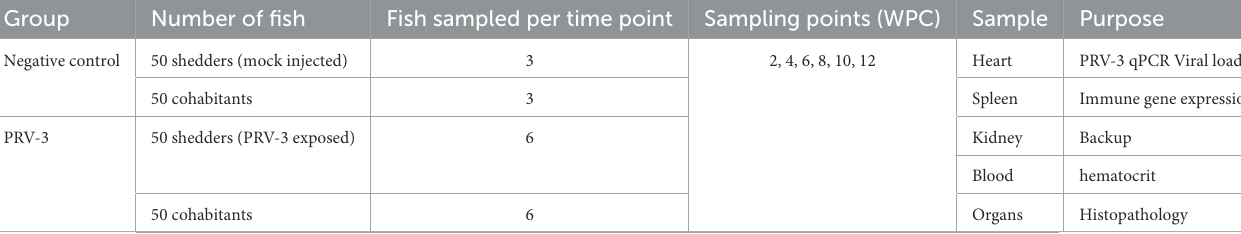
TABLE 1 Sampling plan for all experimental groups (5, 12, and 18 ◦ C). Group